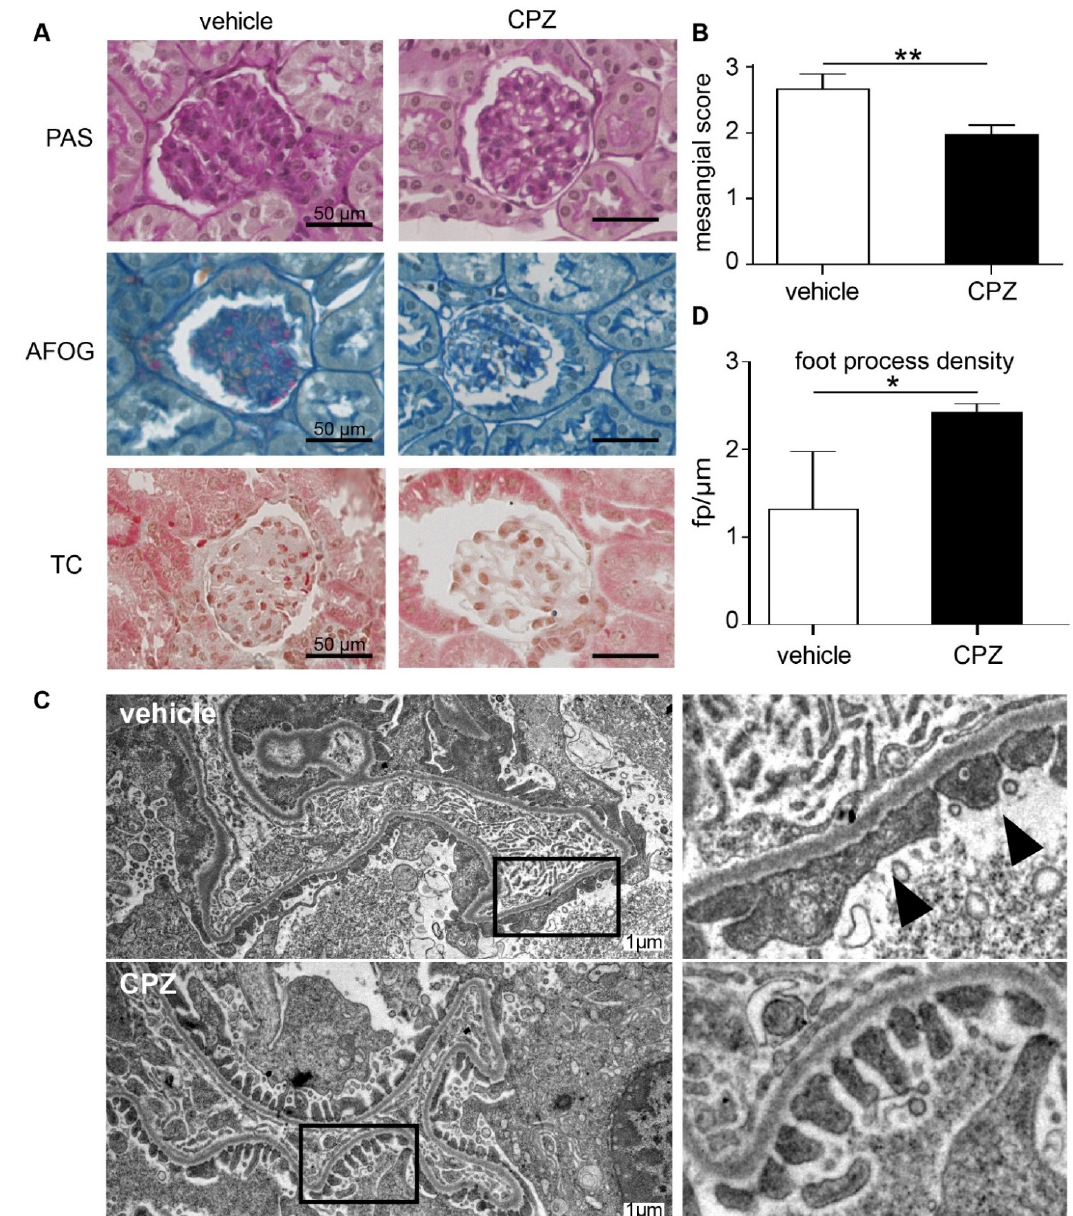
Figure 7. Capsazepine reduces glomerular damage in type 1 diabetic AKITA mice. ( A ) Histologic analysis of diabetic AKITA mice at day 100 of life after 45 days of capsazepine or vehicle treatment. Representative examples of PAS, AFOG, and trichrome staining of glomeruli from mice treated with vehicle (left column) or capsazepine (right column). Vehicle-treated mice show more glomerular damage compared to mice treated with capsazepine. ( B ) The mesangial score quantifying diabetic glomerular damage is significantly reduced in capsazepine-treated mice (means 2.67 vehicle vs. 1.98 CPZ; ** p < 0.01). ( C ) Representative electron microscopy images of kidney samples on day 100 show confined foot process blunting in vehicle-treated mice (arrow heads), whereas CPZ-treated mice show regular foot process morphology (black boxes in left column are regions enlarged in right column). ( D ) Quantification of number of foot processes per micrometer GBM shows higher foot process density for CPZ-treated mice as compared to vehicle controls (means: 1.33 fp/ µ m vehicle; 2.44 fp/ µ m CPZ-treated; * p <